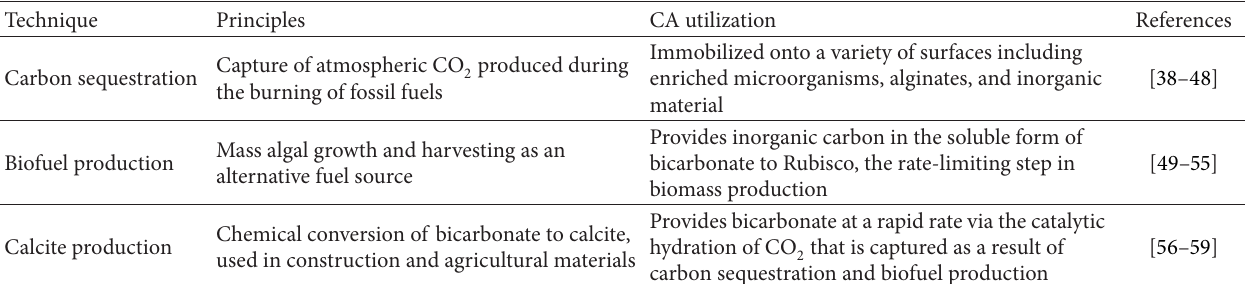
Figure 1: Schematic of the centralized role for CA in converting CO 2 into beneficial products. The catalytic conversion of CO 2 produced during the combustion of fossil fuels into bicarbonate (HCO 3− ) via CA yields a valuable source of inorganic carbon for algal cultures grown in raceway ponds. The lipids and oils from the algae cultures are excellent sources for biofuels, whereas the “waste” product yields additional beneficial proteins, vitamins, minerals, and dietary supplements. The algal CA can also serve as a great source for calcite (CaCO 3 ) production, being critical in many construction, agricultural, and industrial materials. Table 1: CA usage in industrial